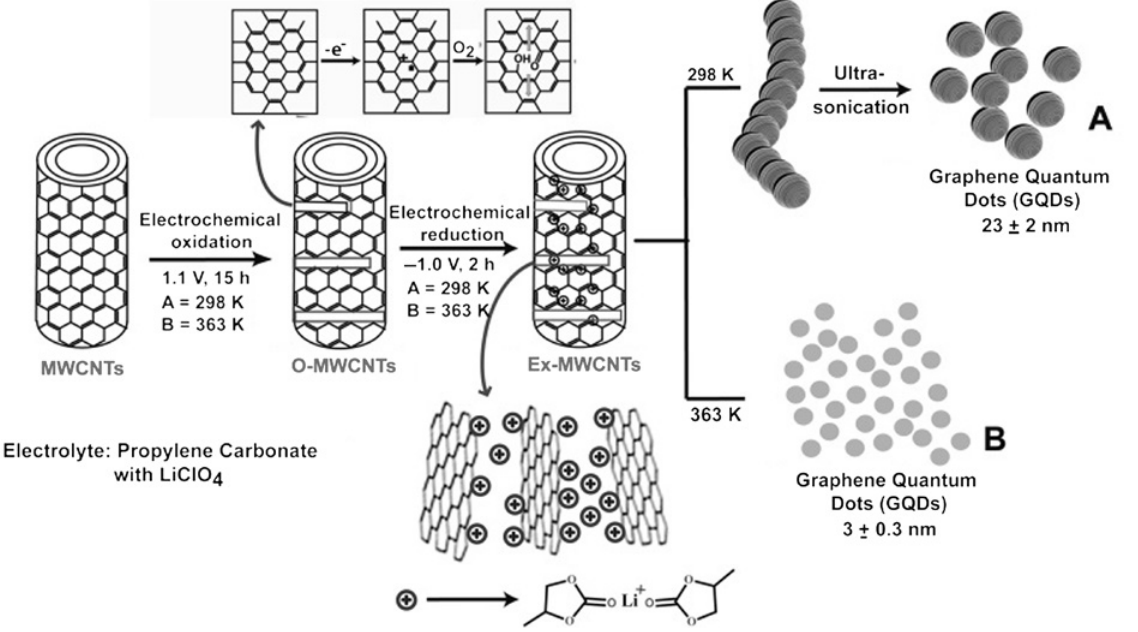
Figure 11: Schematic representation of various processing stages involved in the preparation of photoluminescent GQDs from MWCNTs by this electrochemical approach (reprinted/reproduced with the permission of Ref. [73], copyright 2012, Wiley-VCH Verlag GmbH &